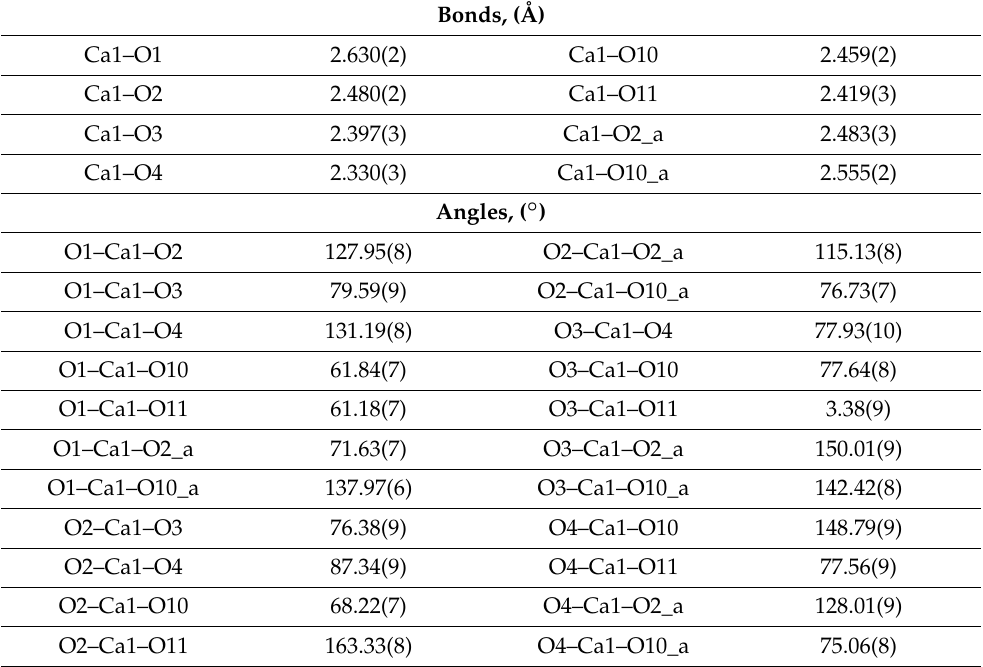
Table 1. Selected geometrical parameters of [Ca(ChA)(H 2 O) 3 ] n .